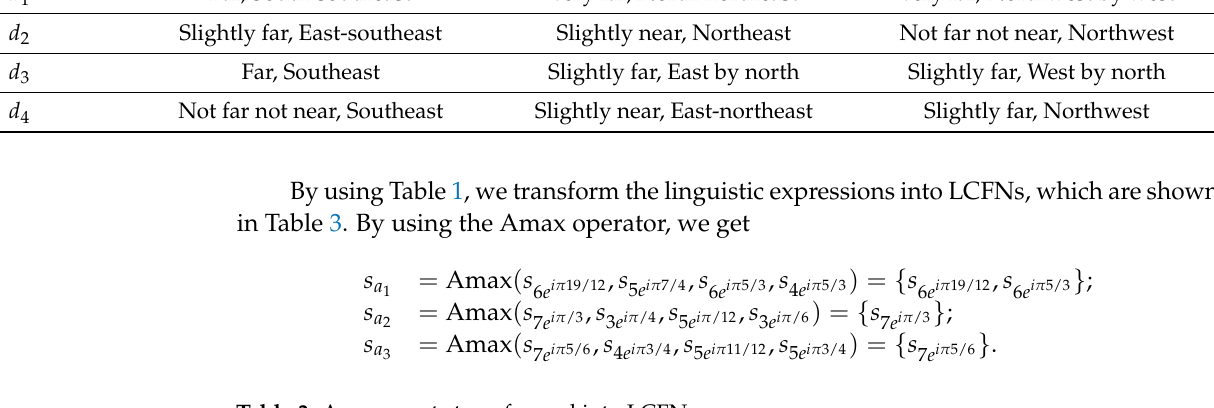
Table 3. Assessments transformed into